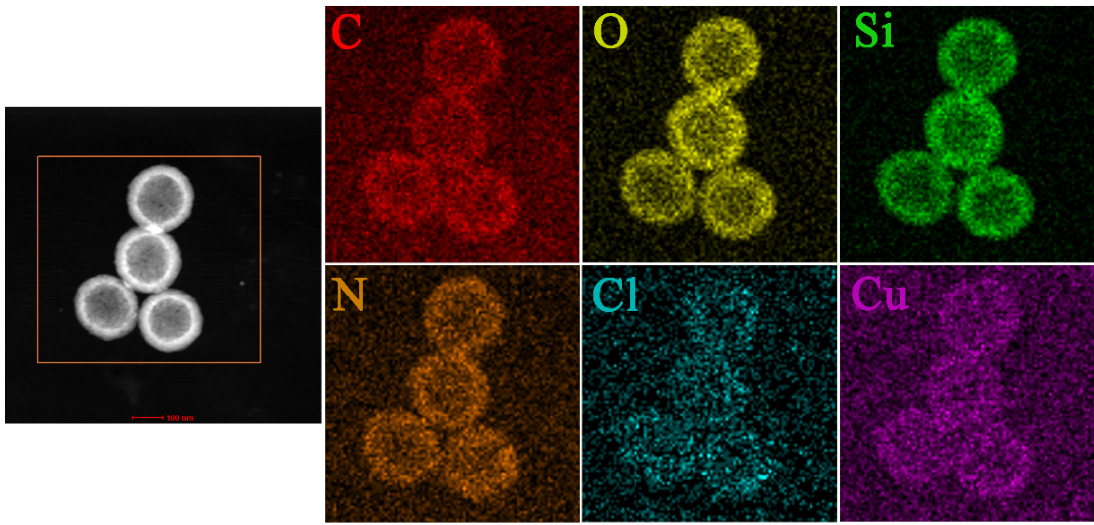
Figure 2. TEM mapping of Pro@HMS-TA-Cu nanoparticles.